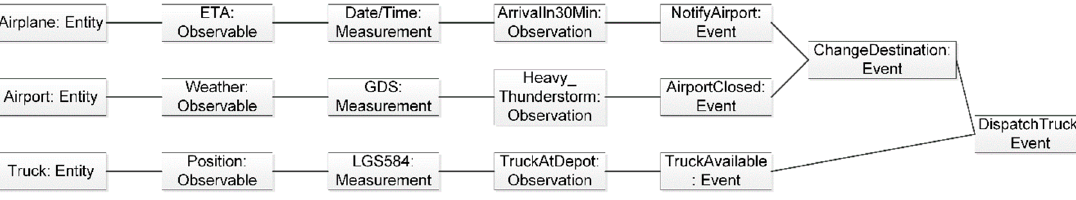
Figure 5. Exception